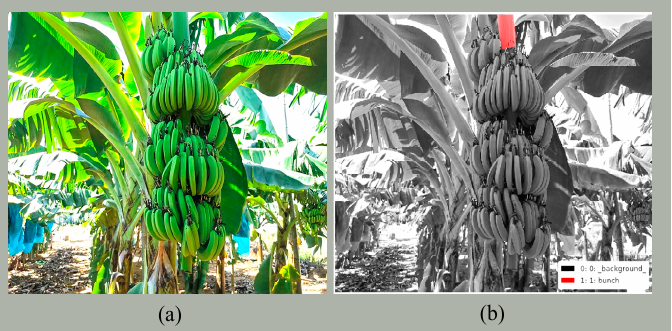
Figure 1. Data sample. ( a ) The original image; ( b ) The training label